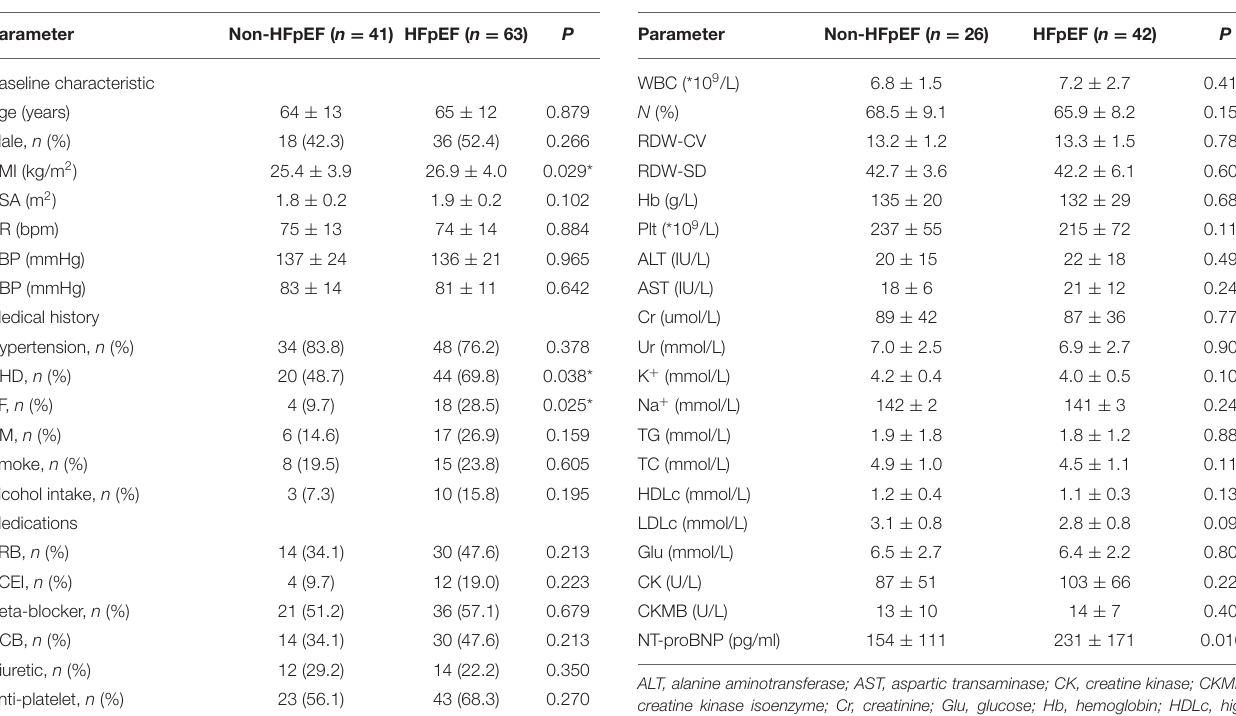
TABLE 1 | Clinical characteristics of patients. TABLE 2 | Laboratory parameters of